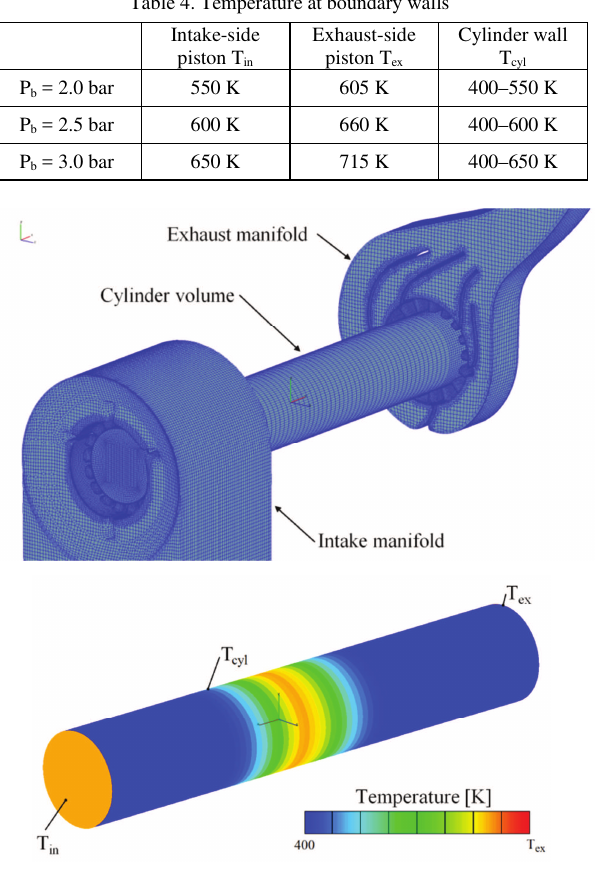
Fig. 6. Numerical mesh and temperature boundary